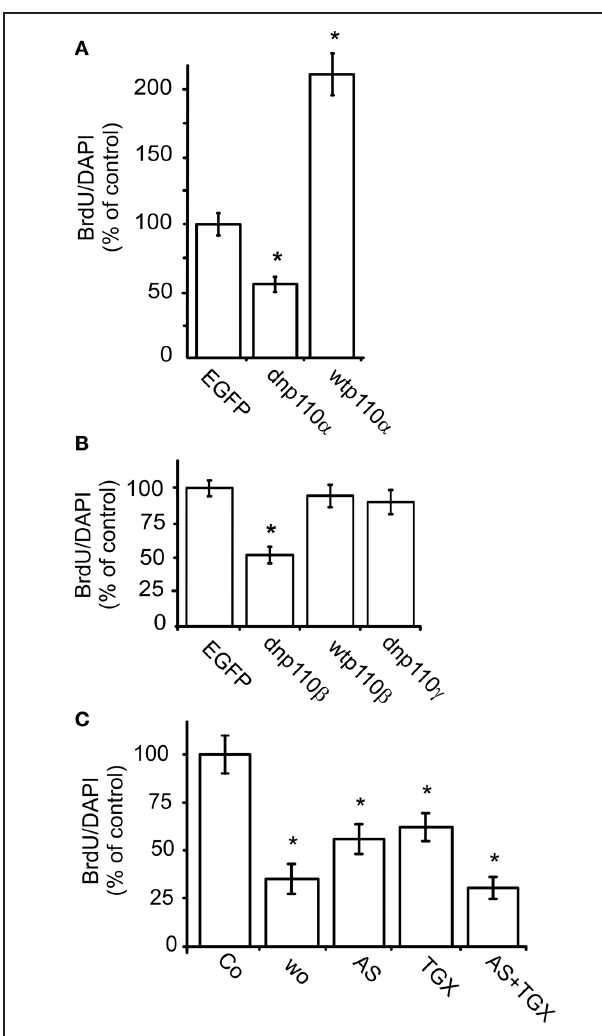
FIGURE 2 | Inhibition of p110 α and p110 β reduces the nuclear uptake of BrdU. (A) Effects of dnp110 α K802R (dnp110 α ) and wtp110 α ( n = 70 ) ; (B) effects of dnp110 β K805R (dnp110 β ), wtp110 β , and dnp110 γ K833R (dnp110 γ ) ( n values between 40 and 60); (C) effects of AS-252424 (5 μ M, AS), TGX-221 (200nM, TGX), and wortmannin (100nM, Wo) ( n values of all